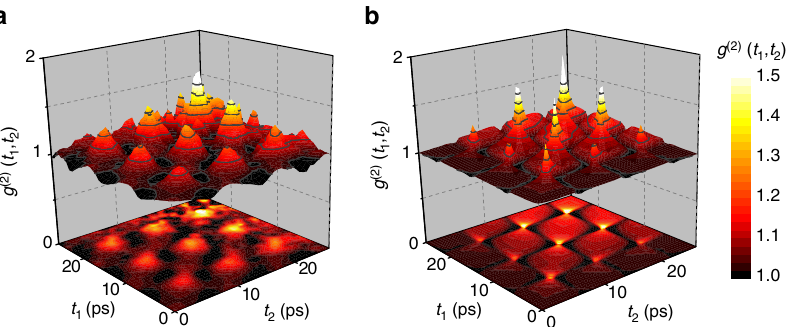
Fig. 3 Two-dimensional correlation function. a Measured g (2) ( t 1 , t 2 ) for the emission from the left mesa. b Simulated g (2) ( t 1 , t 2 ). The arrangement of the regions where g (2) ( t 1 , t 2 ) > 1 in a rectangular grid is well reproduced by the simulations